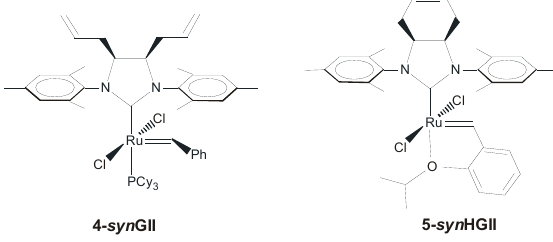
Figure 4. Complexes with olefinic moieties on the NHC.